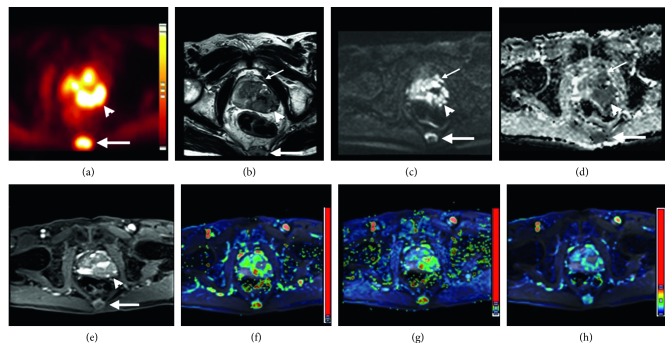
Simultaneous 11C-choline PET/MRI images of the prostate region of a 74-year-old man with prostate cancer. (a) PET, (b) T2WI, (c) DWI, b=1000, (d) ADC, (e) DCE, (f) Ktrans, (g) Kep, and (h) iAUC maps derived from DCE showing tumor invasion of the left levator ani muscle (small arrows) and left gross extracapsular extension (arrowheads) by the primary tumor and bone metastasis at the sacrum (large arrows). Liver metastasis is also depicted on PET/MRI (not shown), and the clinical stage is T4N0M1c. Histological examination of the patient's biopsy specimens revealed a Gleason score of 8 and a prostate-specific antigen level of 591.9 ng/ml before PET/MRI.